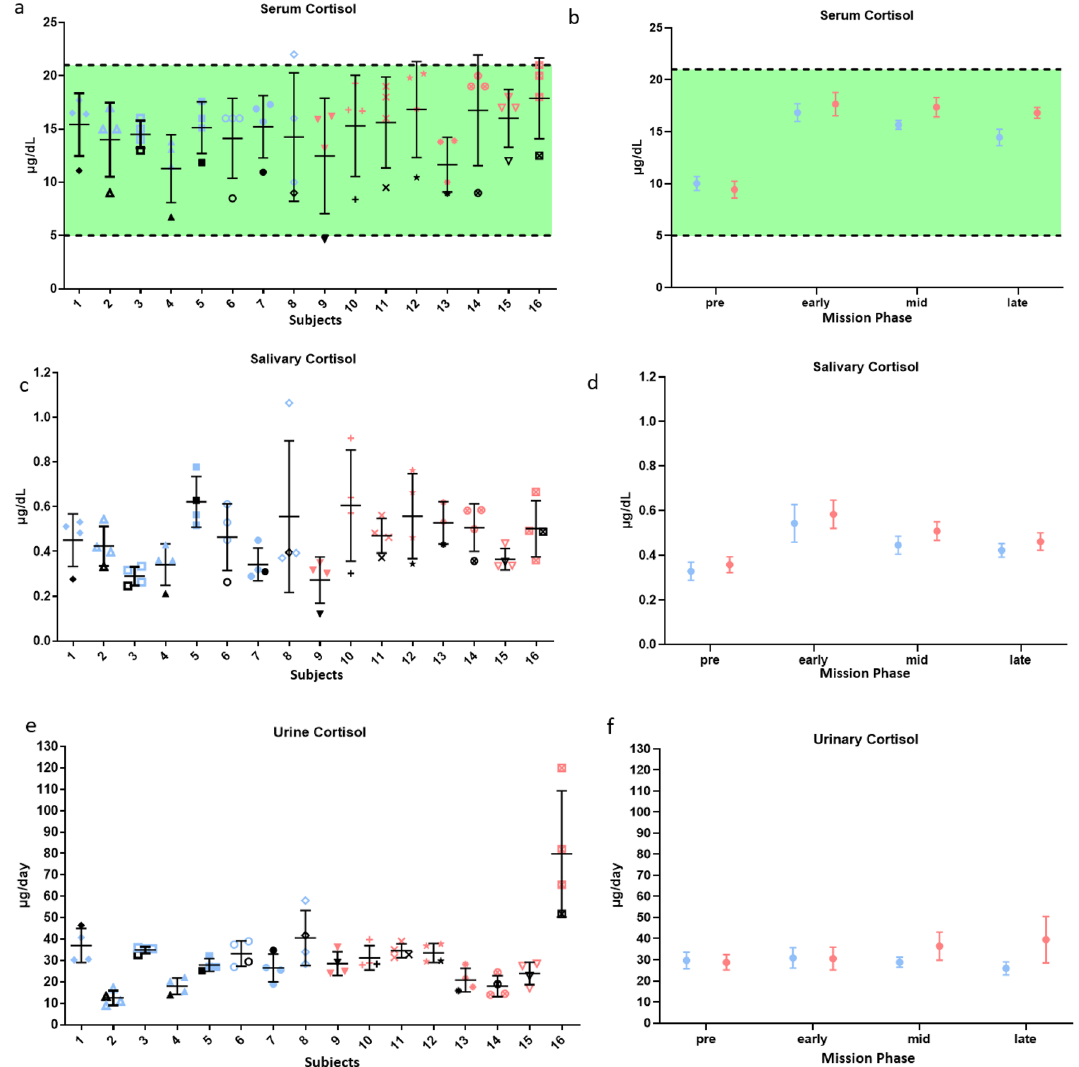
Figure 4. Serum, salivary, and urinary cortisol in-mission compared to pre-mission average. In ( a,c,e ) each vertical set of samples represents one individual on the enhanced diet (blue) or the standard diet (red). Black symbols denote individual pre-mission average. In ( b,d,f ) plots represent the mean ± SE of all subjects on the enhanced diet (blue) or the standard diet (red) during different phases of the mission. Serum cortisol increased more for subjects on the standard diet. Green area represents target intake levels that met requirements. More information is available in SI Appendix , Tables